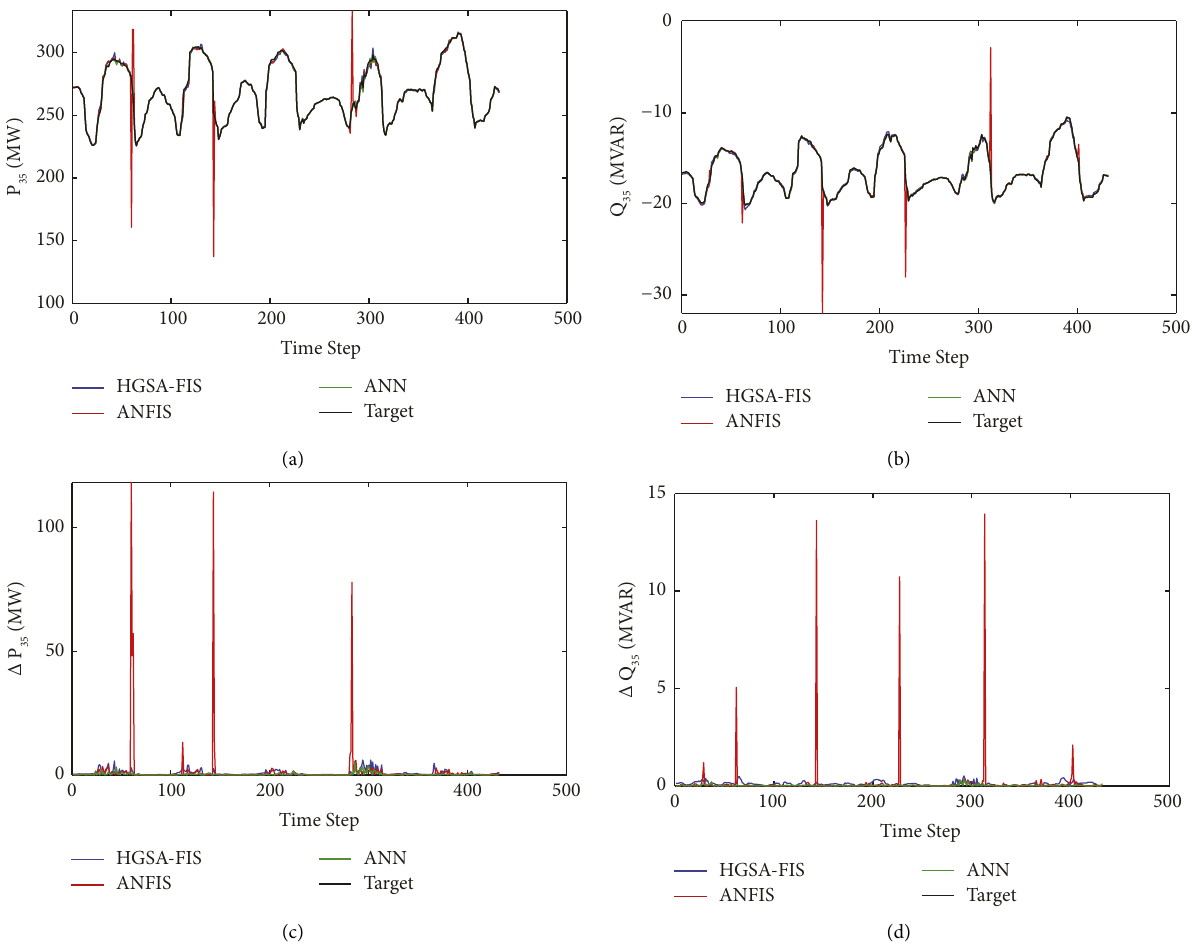
Figure 13: Comparison of prediction accuracy of HGSA-FIS, ANFIS, and ANN models in predicting tie-line L35 power flows: (a) P | , and (d) APE | Δ Q Q , (c) APE | Δ P 35 35